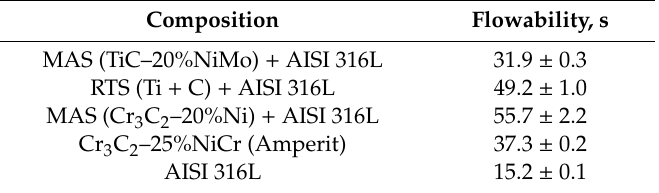
Table 5. Flowability of the experimental compositions and reference